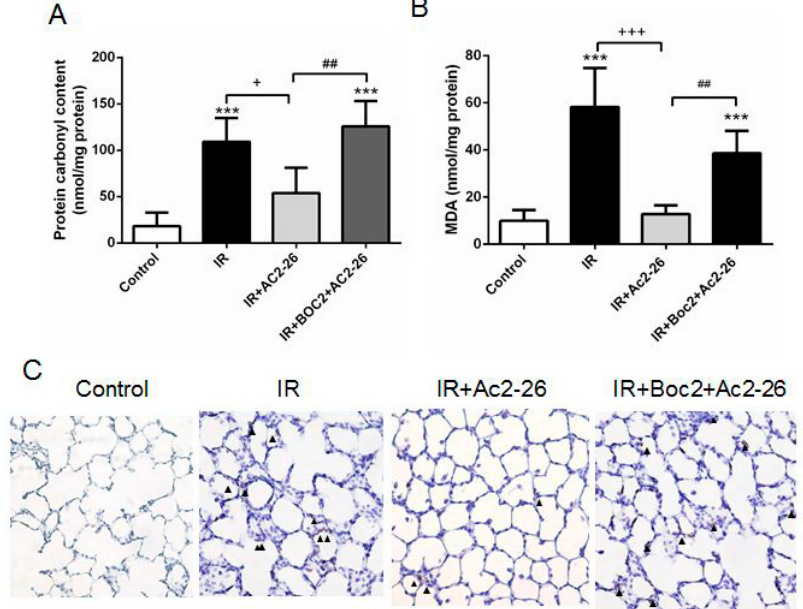
Figure 4. Effect of Ac2-26 and Boc2 on protein carbonyl contents, malondialdehyde (MDA) levels, and myeloperoxidase (MPO)-positive cells in lung tissue. Carbonyl contents ( A ); MDA levels ( B ); and MPO-positive cells ( C ) in lung tissue significantly increased in the IR group. Ac2-26 treatment significantly attenuated these increases. The protective effect of Ac2-26 was abrogated by the addition of Boc2; ( C ) Immunohistochemistry for MPO in the lung (arrowheads indicated MPO-positive cells) (200× magnification). Data are expressed as means ± SD ( n = 6 per group). *** p < 0.001, compared with the control group; + p < 0.05, +++ p < 0.001, compared with the IR group; and ## p < 0.01, compared with the IR + Ac2-26 group.